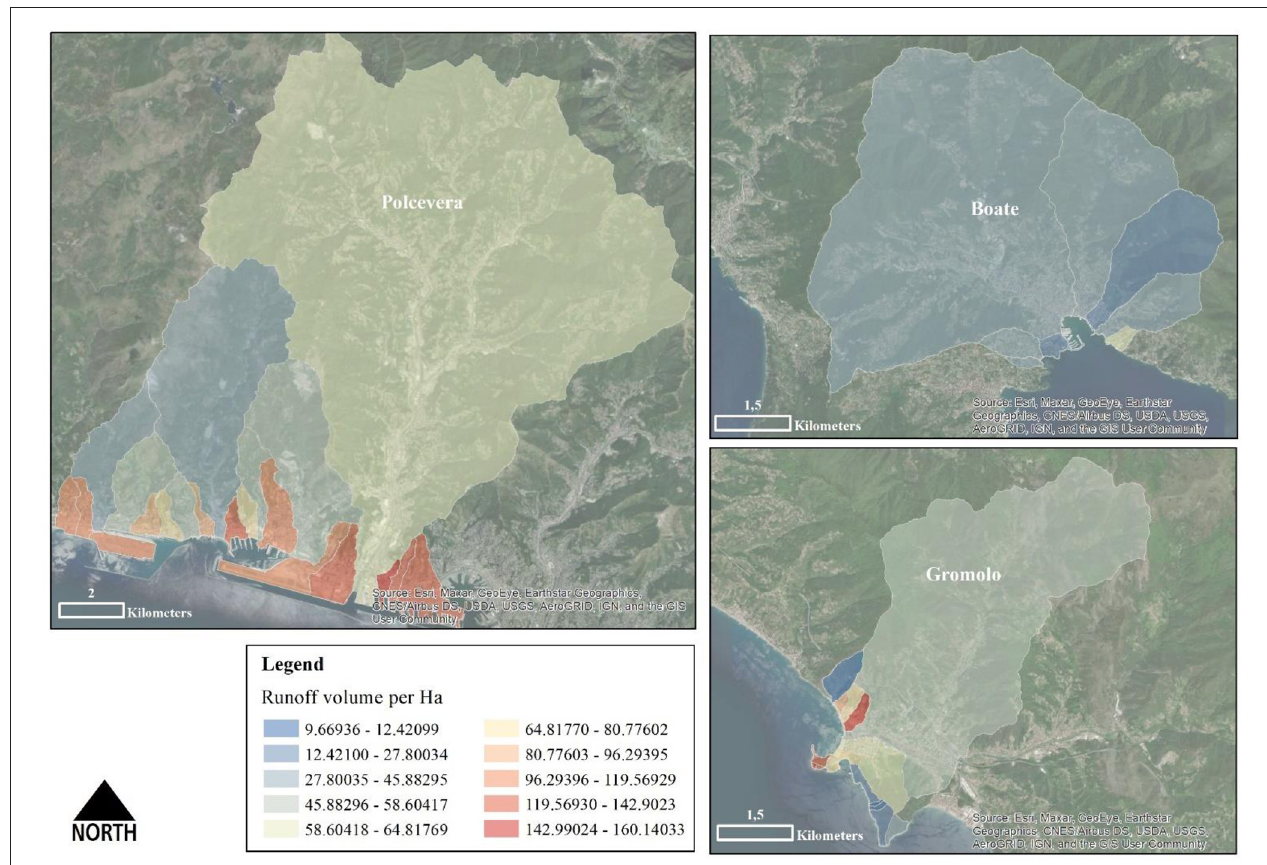
FIGURE 4 | Runoff volume per Ha for each watershed (50mm of rainfall) (source: